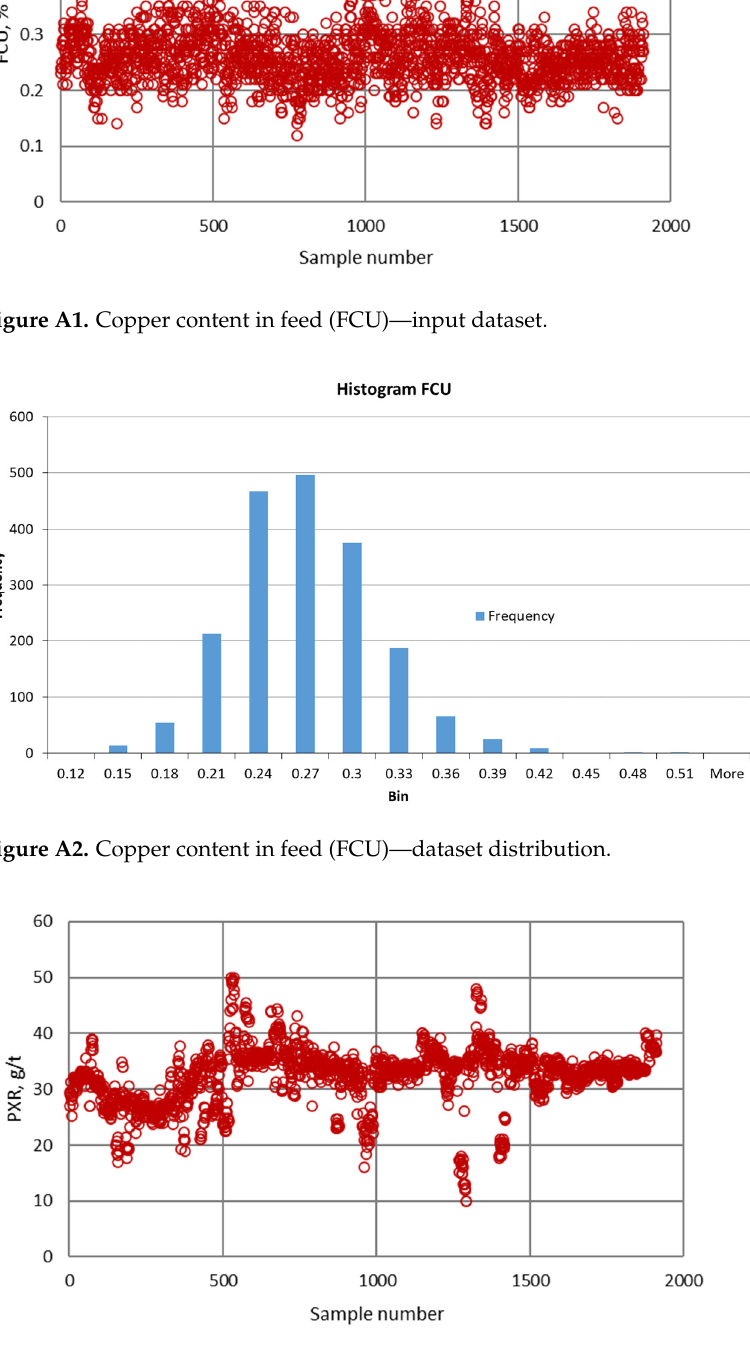
Figure A3. Collector consumption in rougher flotation stage (PXR)—input dataset.